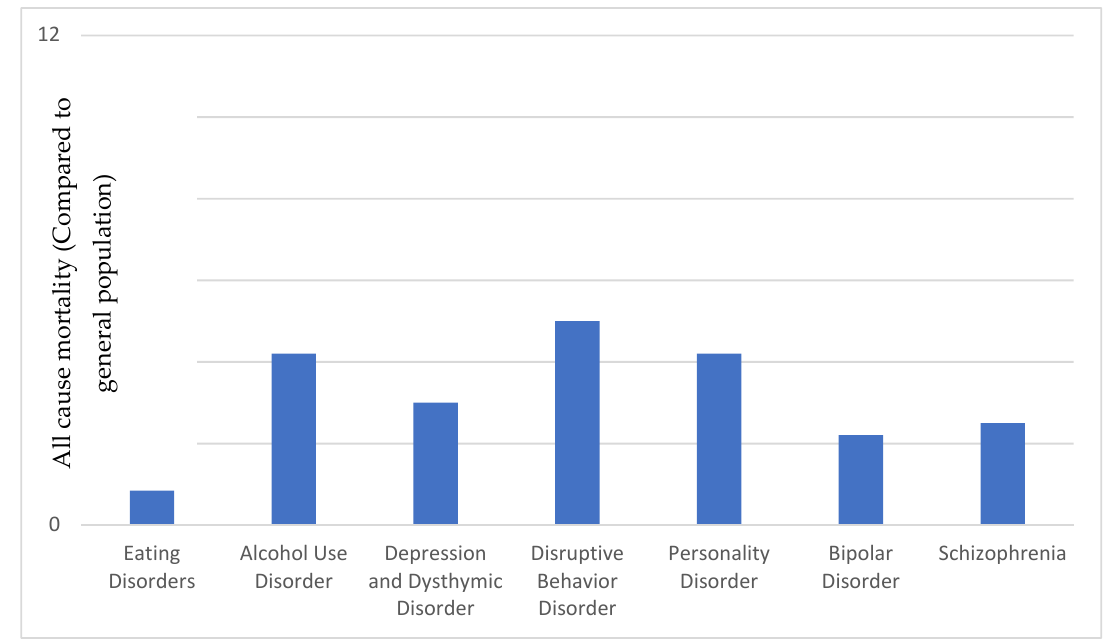
Figure 1. Mental